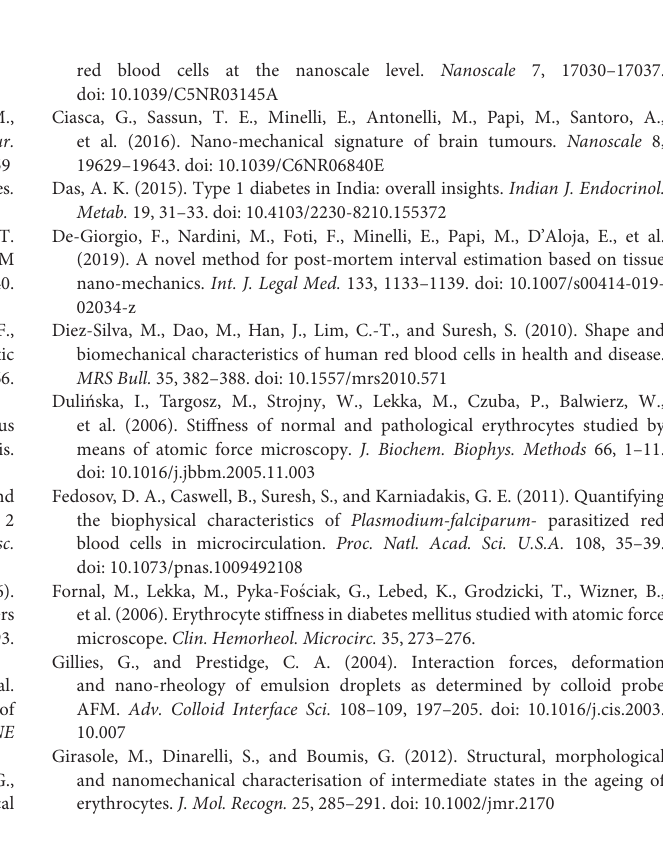
Supplementary Figure 1 | Box plot analysis of the measures performed on the 10 cells measured on the subject. Horizontal lines represent the Mean ± SEM measured on healthy controls. Supplementary Figure 2 | Average time-dependent force relaxation sequences calculated using FR curves acquired on the RBC center on healthy subjects (A) and on the pathological one (B) . The corresponding 95% confidence bands about the mean are also